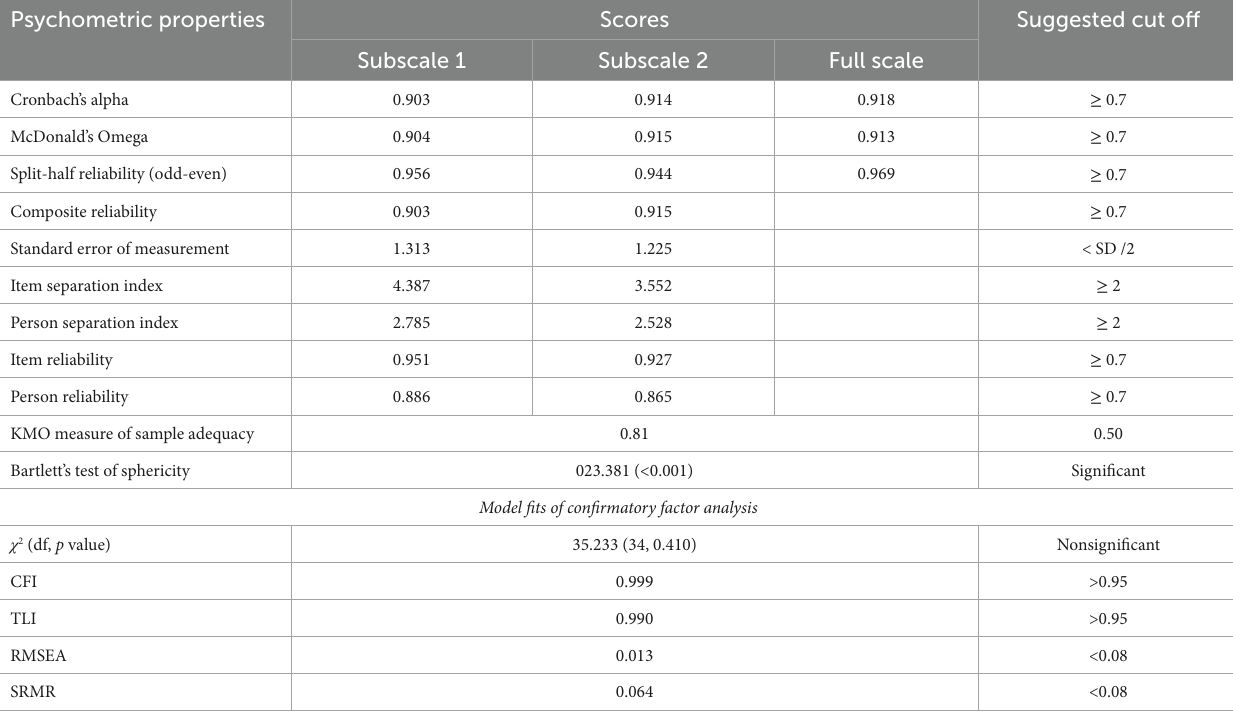
TABLE 3 Scale-level psychometric properties of the 10-item Korean version of